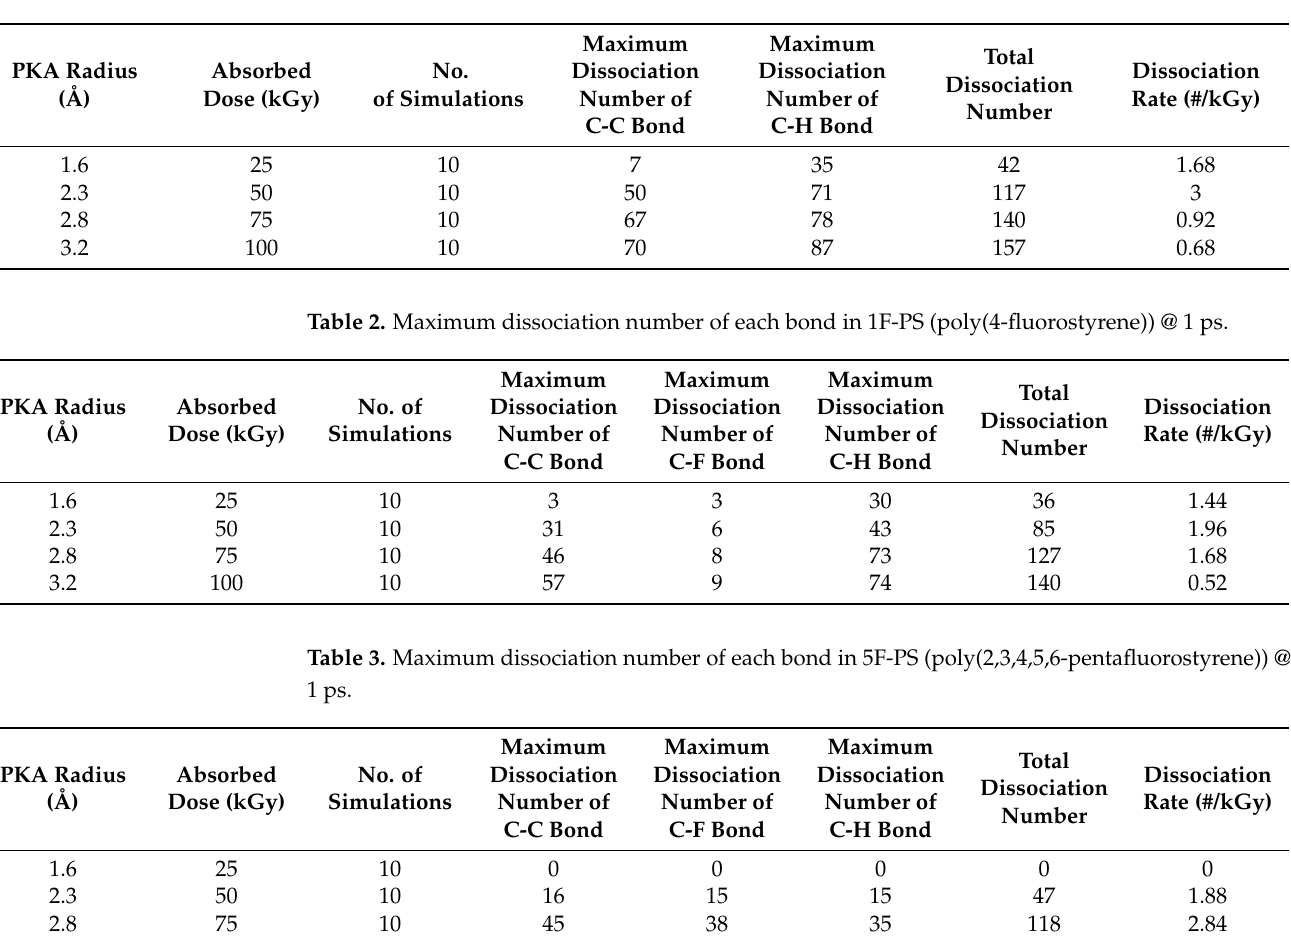
Table 1. Maximum dissociation number of each bond in polystyrene @ 1 ps.